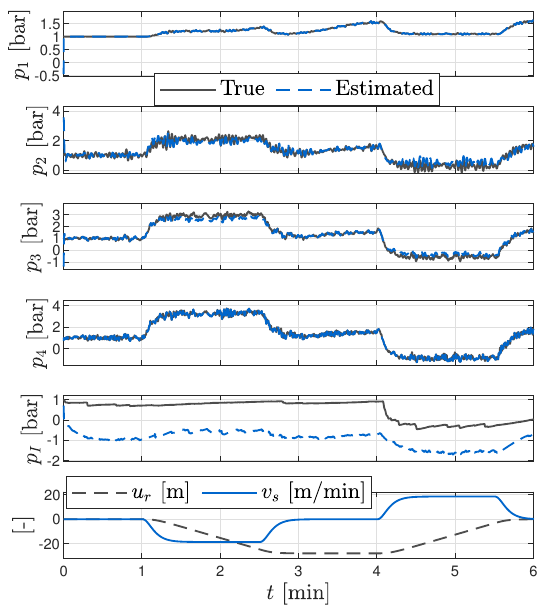
Figure 4: RIH estimated pressure states.